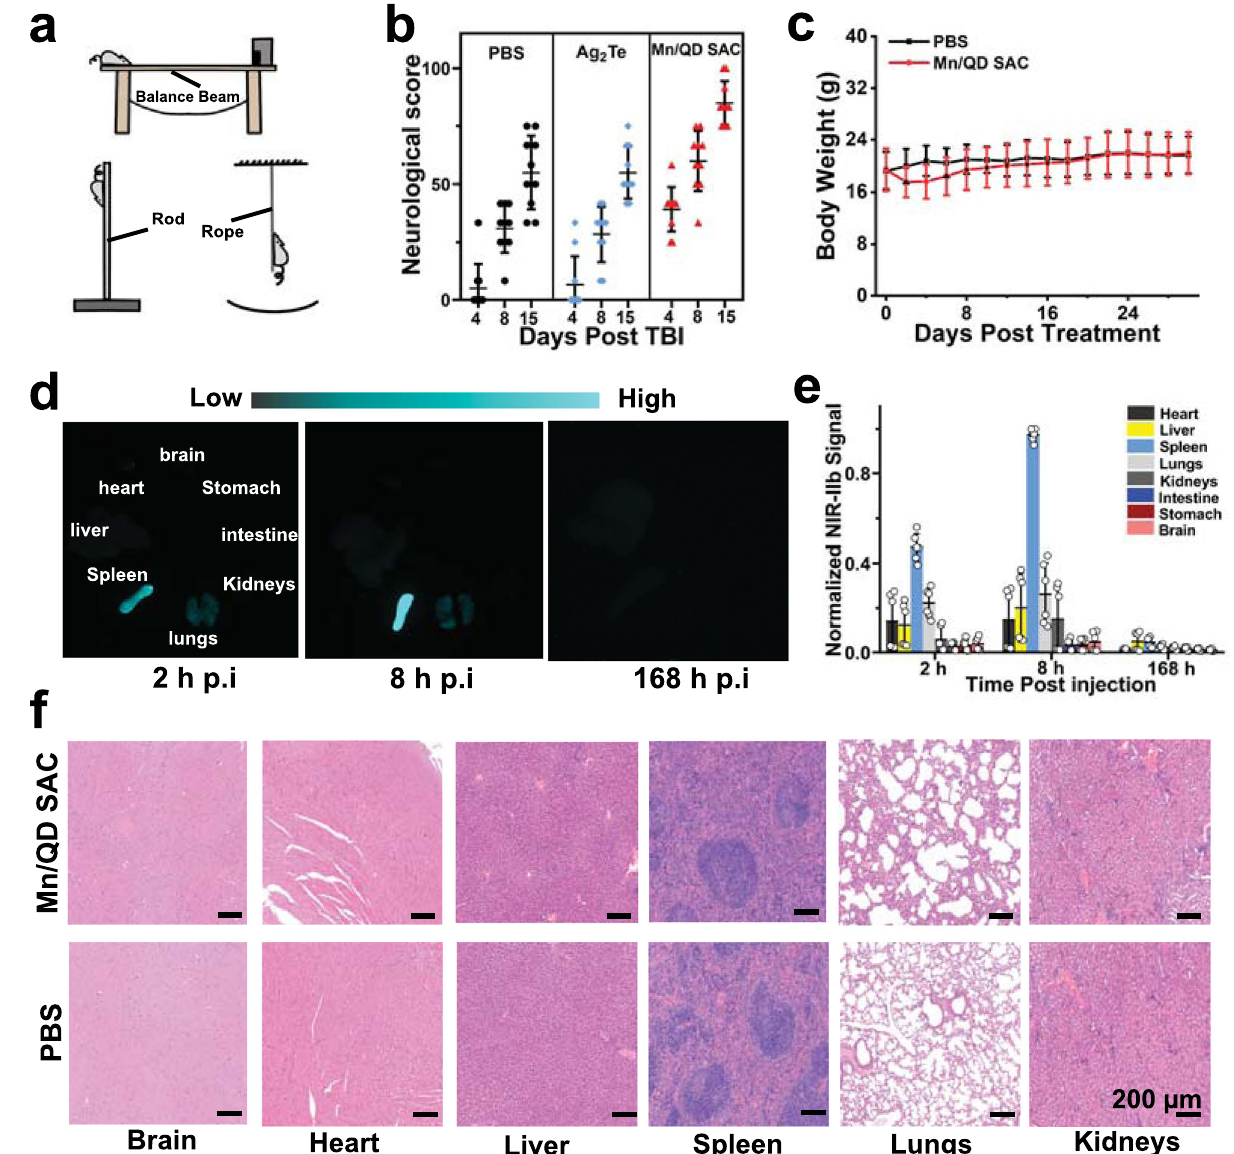
Fig. 7 | Neurological score and biosafety investigation. a Schematic diagram of balance beam experiment, climbing rod experiment and suspension rope experi- ment. b Comprehensiveneurologicalscorebasedonexerciseabilitytests.Dataare presented asmean±SD( n =10 independent samples). c Body weight of miceafter different treatments within 30 days. Data are presented as mean±SD ( n =6 inde- pendent samples). d In vitro NIR-IIb fl uorescence imaging of the main tissues of